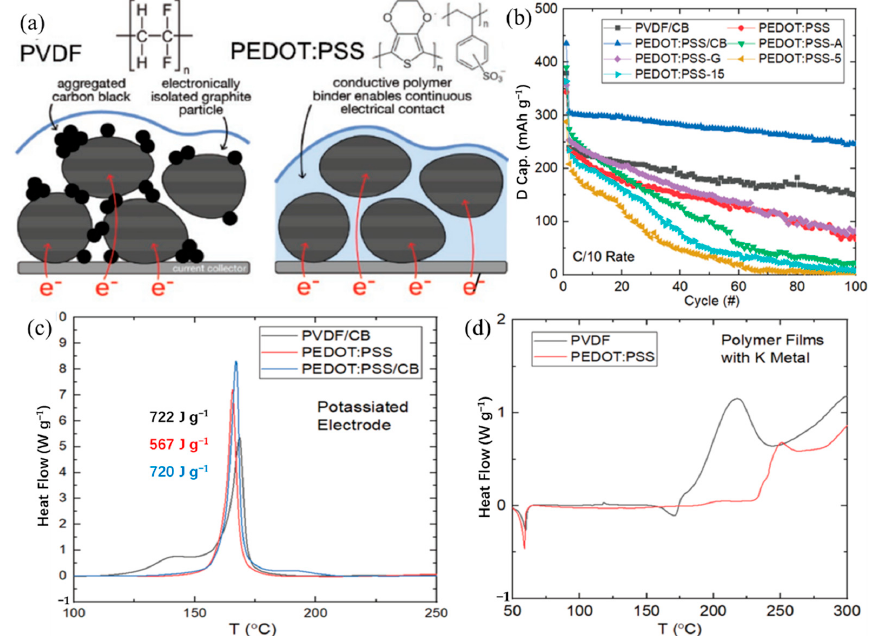
Figure 13. ( a ) Proposed mechanism for improving the performance of the graphite anode in a KIB. ( b ) The capacity performance of graphite half-cells using various binders in KFSI electrolyte with C/10 constant-current rate cycling. DSC profiles for cycled graphite anodes with varying binder compositions with ( c ) 100 SOC, ( d ) 0 SOC and wash. ( a – d ) Reproduced with permission from Ref. [160]. Copyright 2022 Wiley-VCH GmbH.